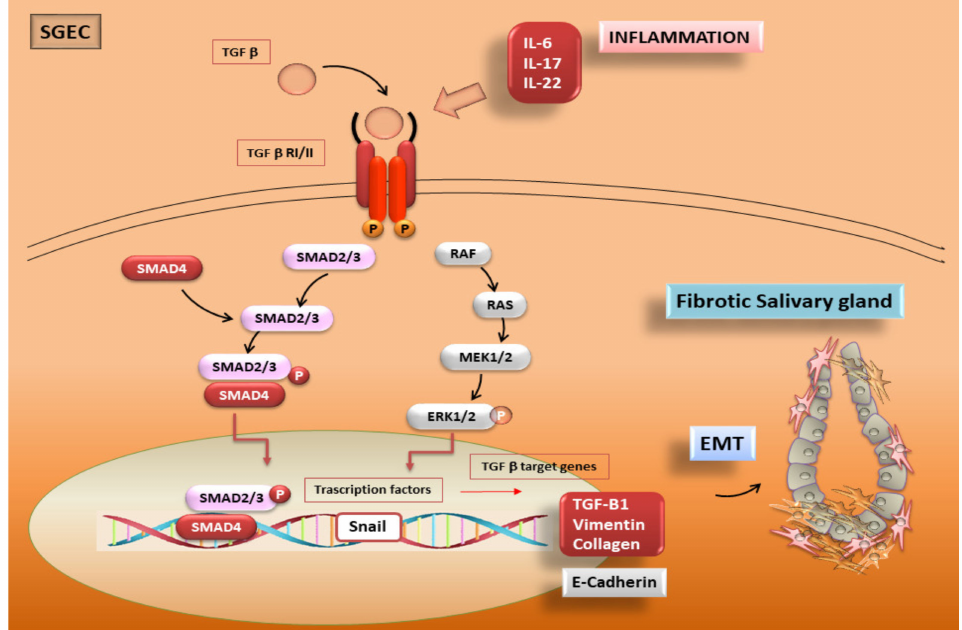
Figure 4. TGF- β /EMT signalling in pSS. TGF- β activates both the canonical SMAD2/3 pathway and the non-canonical MAPK pathway, triggering the EMT process in healthy SGEC. An inflammatory microenvironment including pro- inflammatory cytokines such as IL-17, IL-22, and IL-6 may induce EMT through the TGF- β /SMAD and non-SMAD signalling pathways. TGF- β exerts its cellular effects by linking to the TGF- β type I/ II receptor, and this binding leads to the activation of SMAD2/3 canonical signalling. Phosphorylated SMAD2/3, with cofactor SMAD4, form a heteromeric complex, which translocates to the nucleus to mediate signalling events linked to EMT activation. The activation of the transcription factor Snail and the induction of EMT markers have the consequence of upregulating the mesenchymal markers Vimentin and Collagen Type 1 and downregulating the epithelial marker E-Cadherin. During the activated EMT program, salivary epithelial cells exhibit dramatic morphological changes and the acquisition of mesenchymal properties, including an increased migratory capacity and contractility. Finally, these mesenchymal cells become myofibroblasts, which are responsible for progressive SG fibrosis. Alternatively, TGF- β can deliver signals via non-SMAD pathways, such as the MAPK signalling cascade including phosphorylated ERK1/2. The ERK1/2 signalling pathway has a complex and crucial correlation with the TGF- β 1 system in controlling the EMT